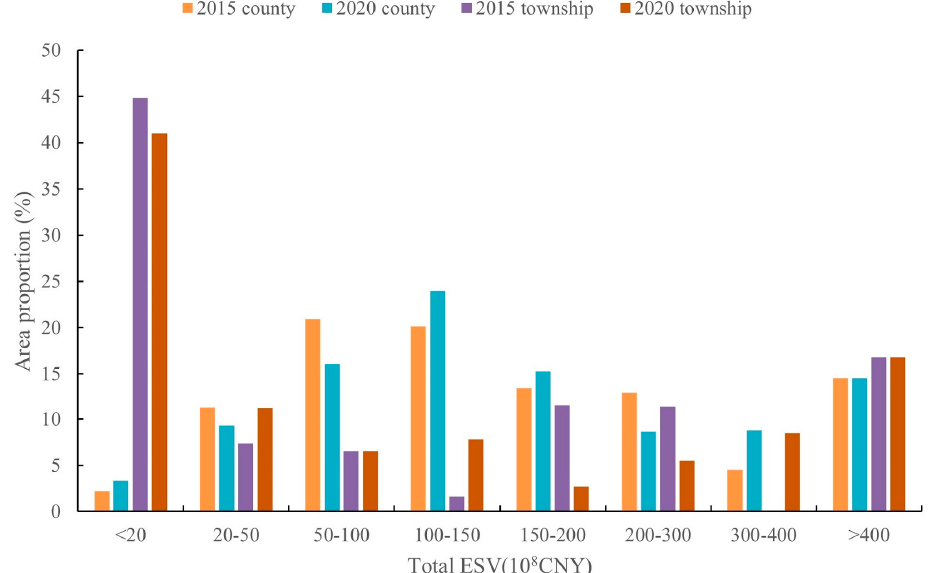
Figure 11. Area proportion ESV totals of the study area at township and county scales in 2015 and and 2020.